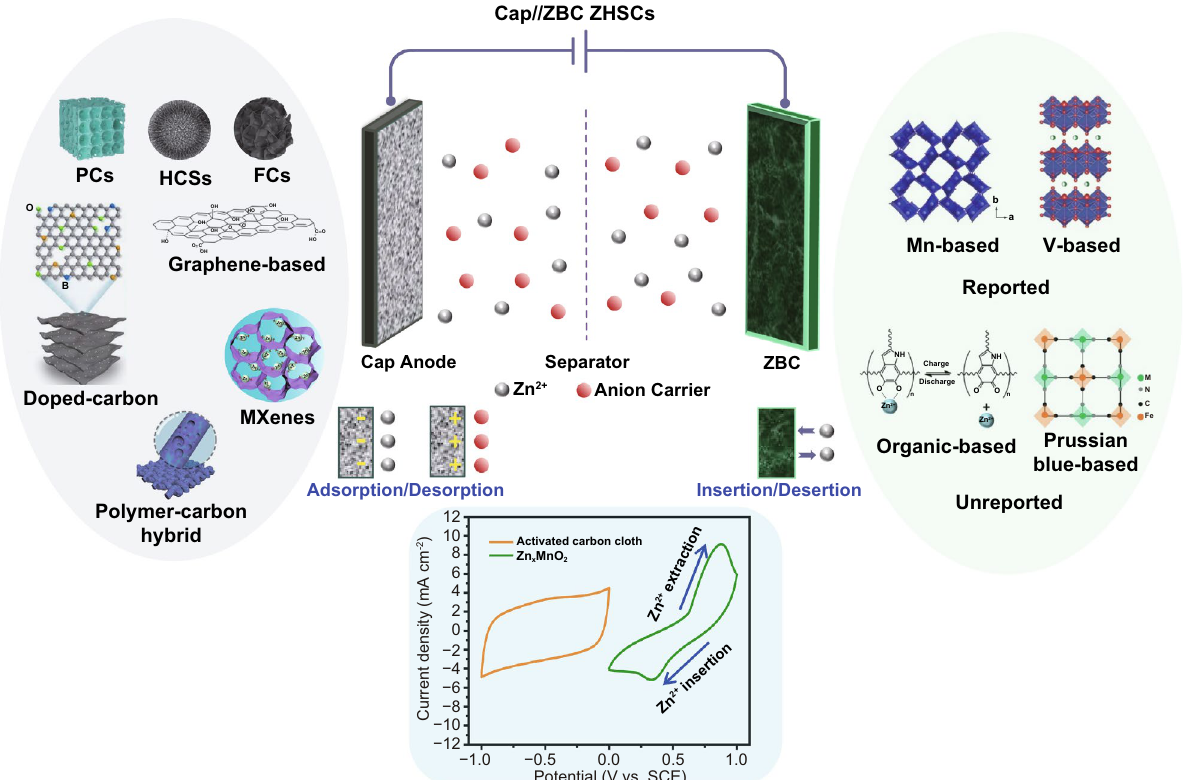
Fig. 7 Schematic illustration (Cap anodes, ZBC, energy storage mechanisms and CV behaviors) of Cap//ZBC